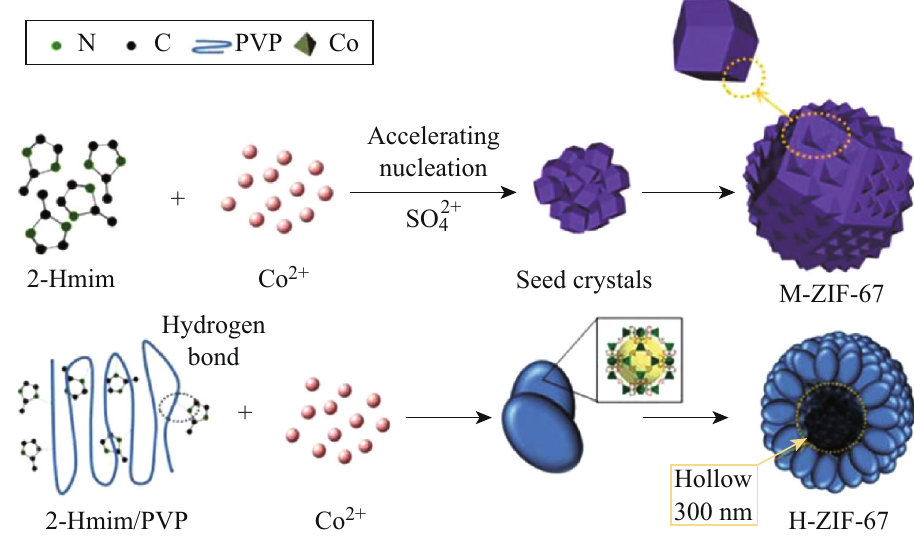
Fig. 3 Schematic diagram of the preparation of a M-ZIF-67 and b H-ZIF-67